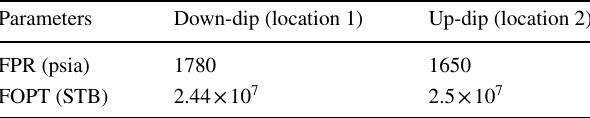
Table 10 Performance evaluation during up-dip and down-dip injec- 2 and CO 2 -WAG numerical